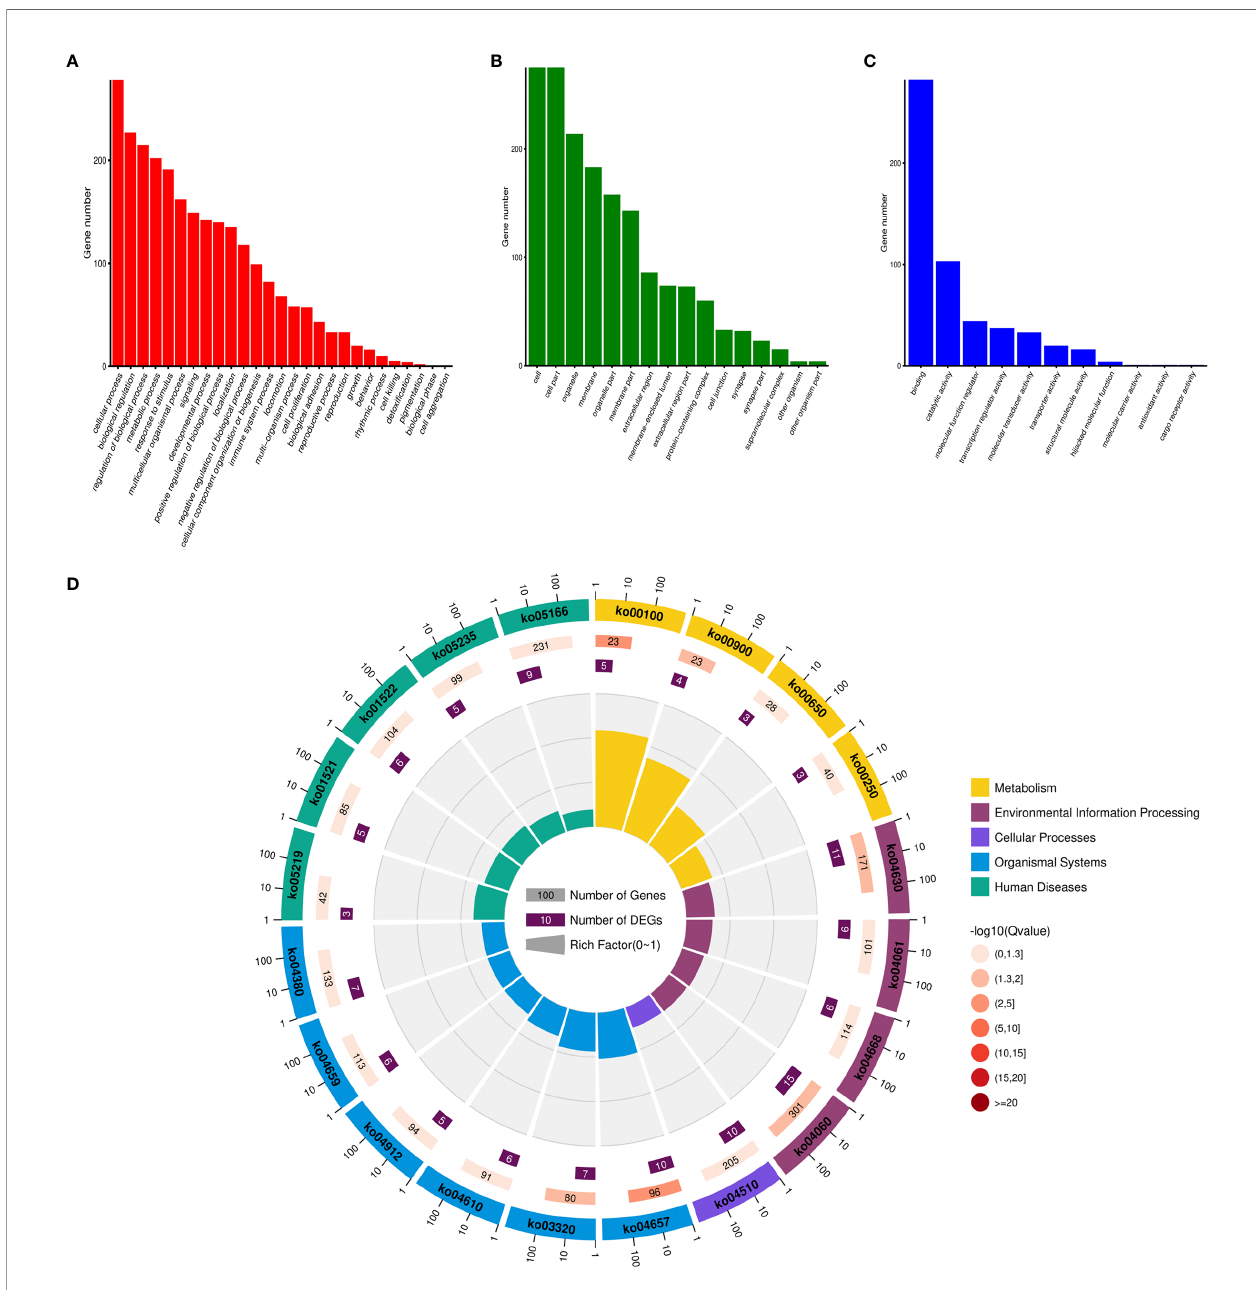
FIGURE 4 | The enrichment analysis of the ceRNA network. (A) Biological Process GO enrichment analysis of the ceRNA network. (B) Cellular Component GO enrichment analysis of the ceRNA network. (C) Molecular Function GO enrichment analysis of the ceRNA network. (D) KEGG enrichment analysis of the ceRNA